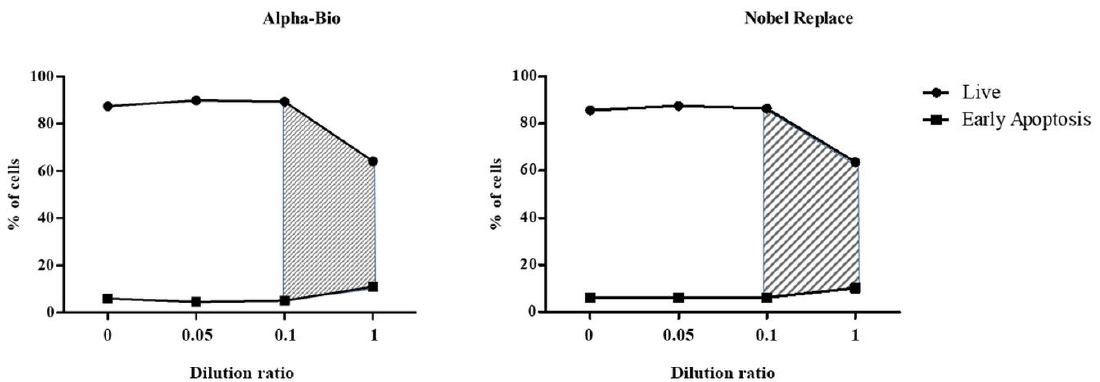
Figure 10. Range of the critical dilution ratios of supernatants containing NSMP from Nobel Replace and Alpha-Bio for the development of apoptosis.